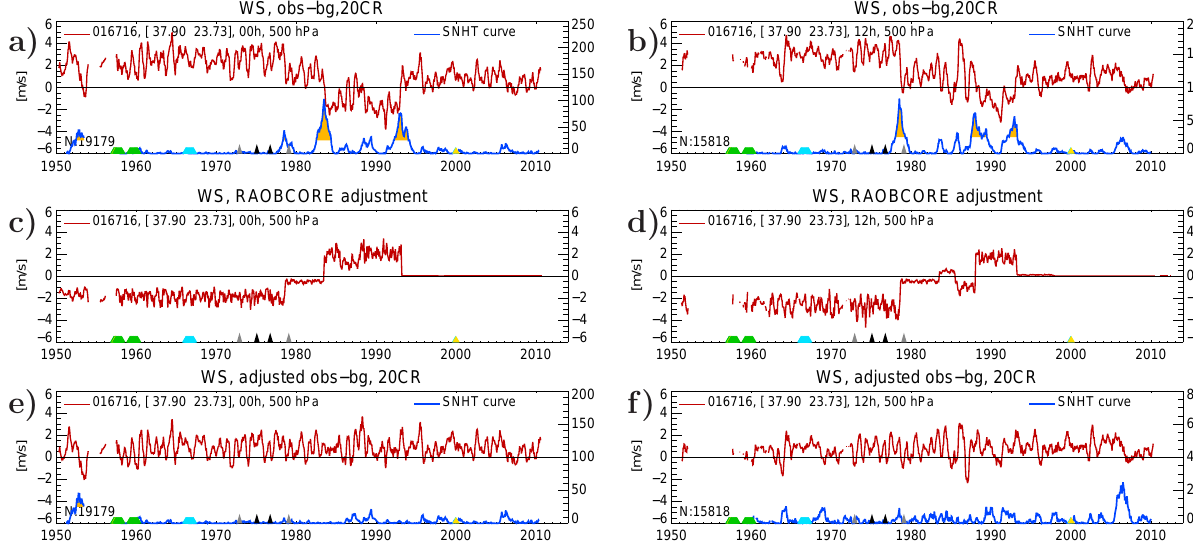
Figure 9. Wind speed innovations (upper row, red curves) at Athens, Greece, WMO ID 016716, at 300hPa, at (a) 00:00UTC and Figure 9: Wind speed innovations (upper row, red curves) at Athens, Greece, WMO ID (b) 12:00UTC. Blue curves are SNHT time series, (c, d) are corresponding adjustments and (e, f) are corresponding adjusted innovations. 016716 at 300 hPa, at a) 00 GMT and b) 12 GMT. Blue curves are SNHT time series. c,d) corresponding adjustments and e,f) corresponding adjusted innovations τ dd (t i ) time series with the NOAA-20CR winds as reference While the US wind network was established already very at 850 hPa for (a) wind direction and (b) wind speed. The early with up to 60 stations in the 1930s, it had some prob- SNHT test statistic reaches very high values for wind direc- lems with measuring the wind direction. The raw observa- tions show visible shifts, e.g., in the wind direction time se- tion. The breaks are very similar for wind direction at other levels (Fig. 7). In these early years the ascents did not reach ries of station 072764 (Bismarck, North Dakota, USA) in very high levels and already at 500 hPa the SNHT (blue line, Fig. 2. Shifts are visible at all the available pressure levels in the years 1938 and 1948. The shifts are much more clearly right axis) can be calculated only after 1945. After visible in Fig. 6a. It shows the wind direction innovations